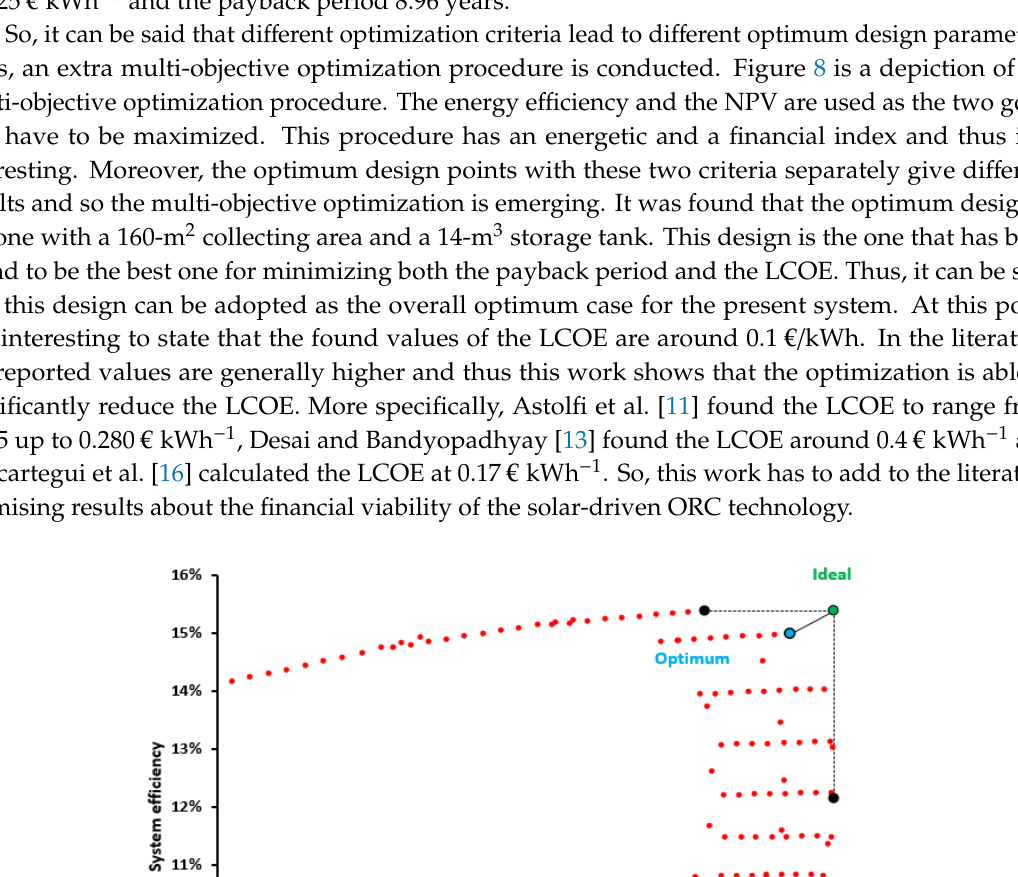
Table 6. Optimum collecting areas for different storage tank volumes for maximizing the net present value.